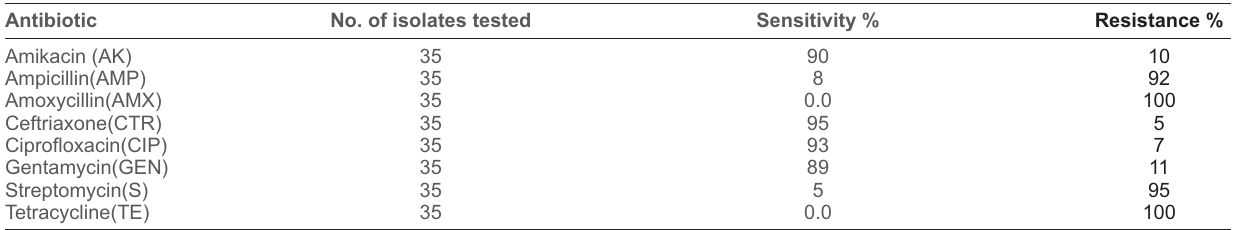
Table-1. Antimicrobial susceptibility pattern of isolate from cattle faeces and soil E. coli